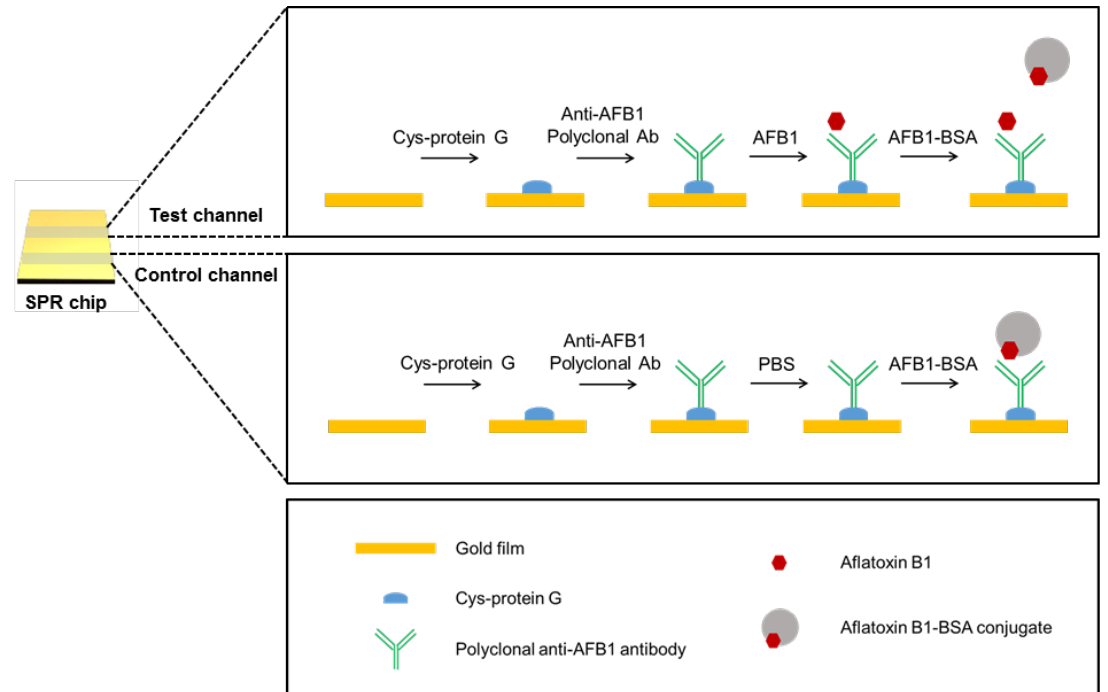
Figure 2. Schematic illustration of aflatoxin B1 (AFB1) detection using the portable SPR sensor.